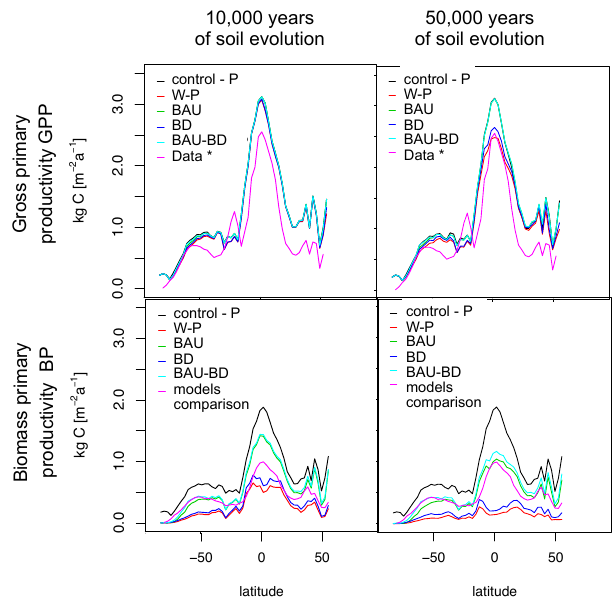
Figure 9. GPP (top panels) and BP (bottom panels) zonal aver- ages after 10000 (left panels) and 50000 (right panels) years of soil formation. Different scenarios considered are compared with data- based estimated GPP (Beer et al., 2010) and model-based estimated NPP (Cramer et al.,